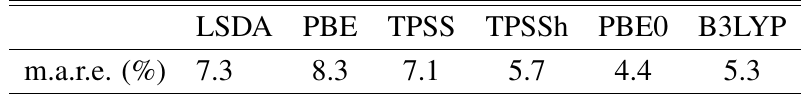
Table 10. Mean absolute relative error (m.a.r.e.) of the atoms and molecules listed in Tables 1–